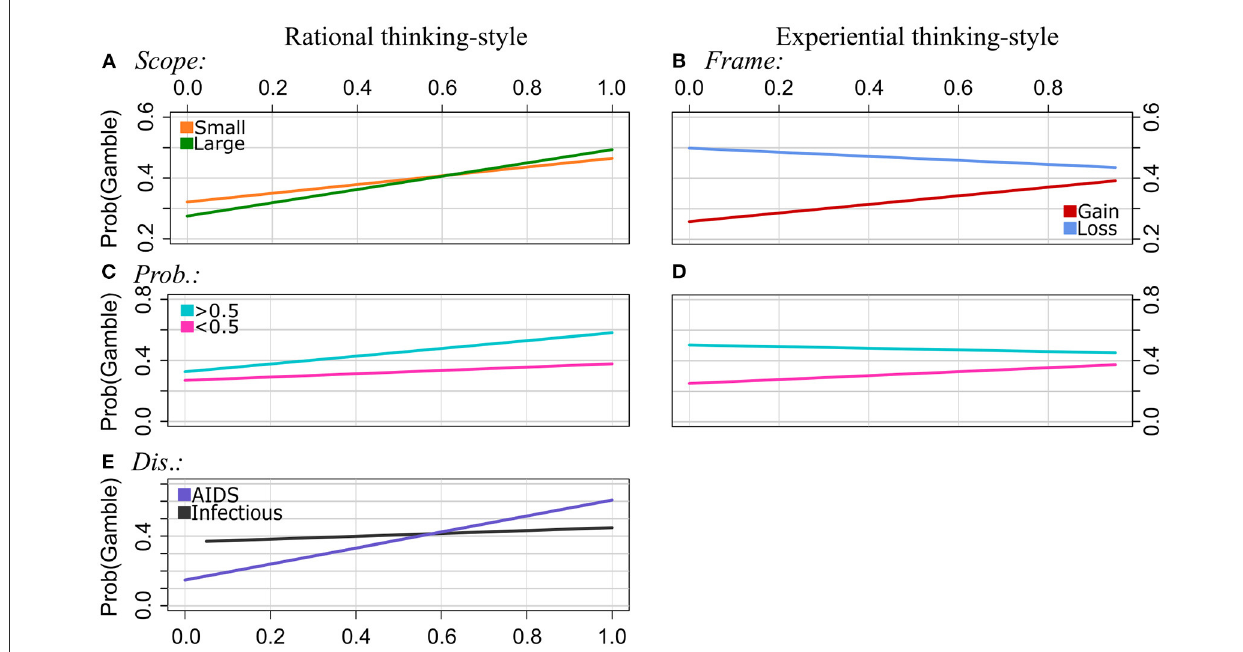
FIGURE4 Experiment 2: Regression lines of the proportions of choosing the gamble option as a function of rational thinking-style (left column) and experiential thinking-style (right column), separately for the levels of Scope [pattern (A) , interaction effects of EX by Scope was n.s.], Frame [ (B) , interaction effects of RA by Frame was n.s.], Probabilities (C, D) , and Disease [ (E) , interaction effect of EX by Disease was n.s.]. Note that we applied a smaller range of values on the y-axis for the plots of the patterns (A, B, E) to illustrate the interaction effects more clearly.